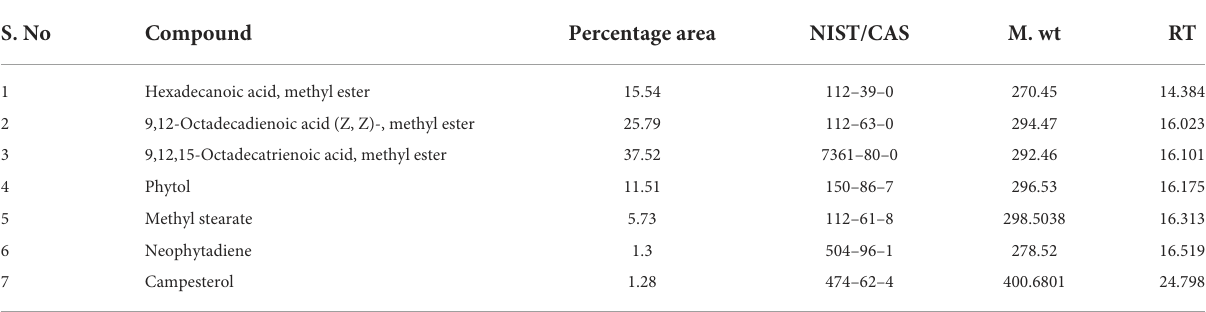
TABLE 4 Identified compounds in B. aurea leaves by the GCMS